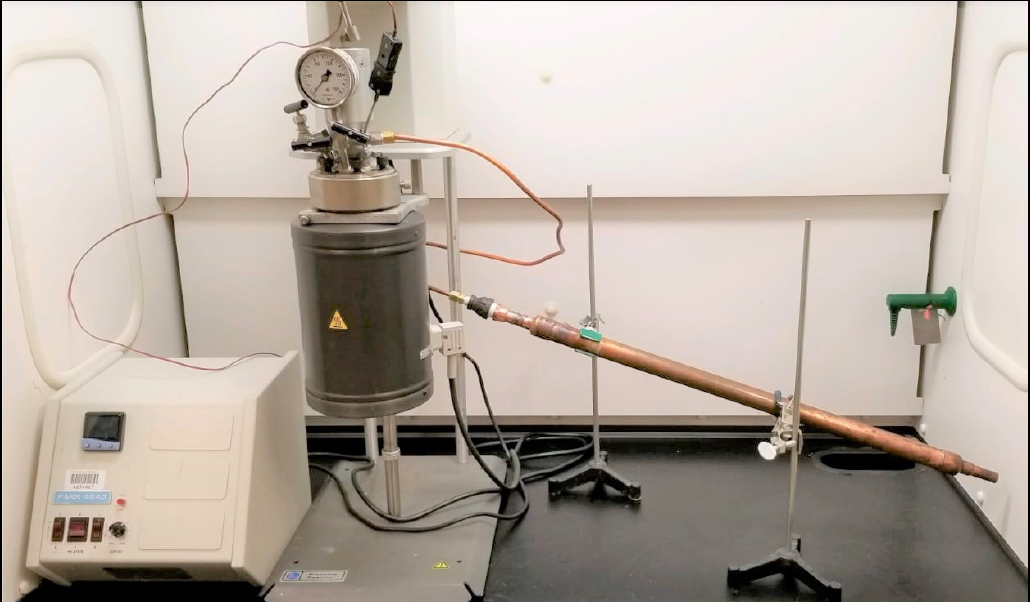
Figure 3. Parr reactor and Parr 4843 controller setup for slow-pyrolysis experiments.